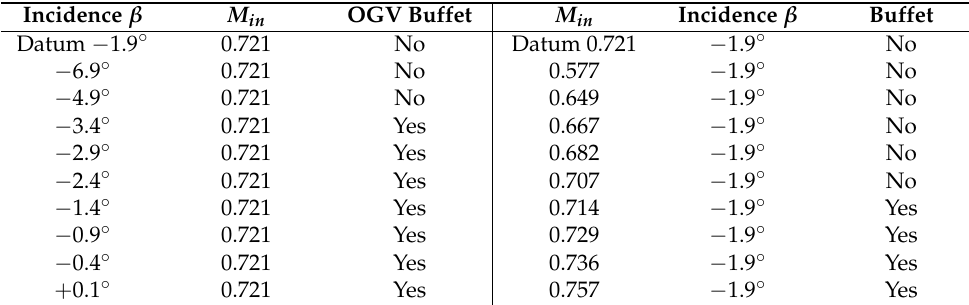
Table 1. Parametric study simulation tranche